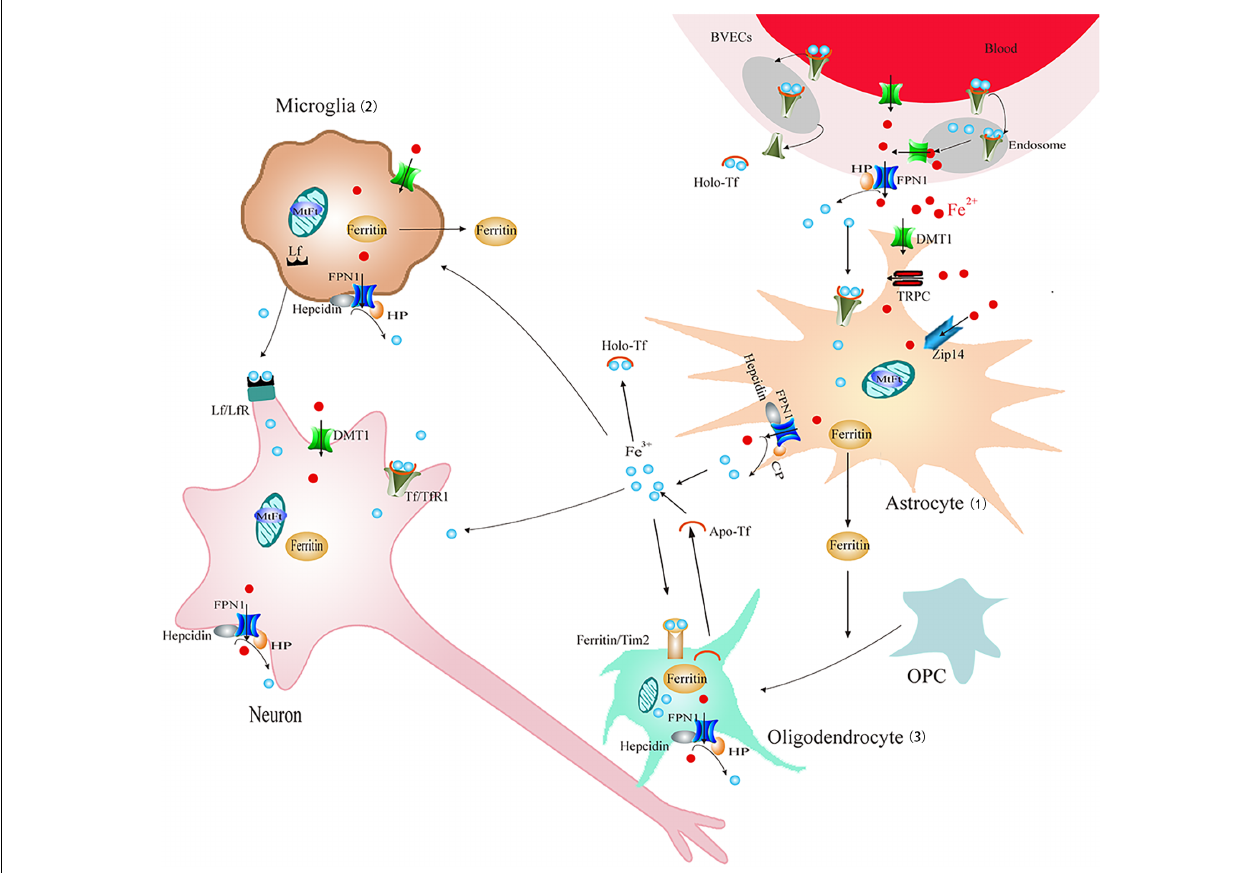
FIGURE 2 | Schematic illustration of brain iron metabolism. Iron could cross BBB though endocytosis of holo-Tf followed by iron detached from Tf inside endosomes and FPN1-mediated iron efflux or transcytosis of holo-Tf through the BVECs. (1) Astrocyte: astrocytes could uptake Fe 3 + via Tf-TfR1. DMT1, Zip14, and TRPC participate in Fe 2 + absorption. Cp can oxidize Fe 2 + to Fe 3 + and then promote FPN1-mediated Fe 2 + release. Iron can be stored in ferritin efficiently. (2) Microglia: Fe 2 + could be transported via DMT1-mediated iron import and FPN1-mediated iron export. Microglia also can transfer Fe 3 + ions to neurons by Lf/LfR-mediated pathway and store iron in ferritin. (3) Oligodendrocytes: iron is stored in oligodendrocytes mainly in the form of ferritin or Tf. Tf could be released from oligodendrocytes. Tim2-induced ferritin uptake is considered as the main mechanism for iron intake. Ferritin released from astrocyte and microglia promotes OPC maturation. BBB, blood–brain barrier; BVECs, brain capillary endothelial cells; Cp, ceruloplasmin; FPN1, ferroportin1; Lf/LfR, lactoferrin/lactoferrin receptor; NTBI, non-transferrin-bound iron; OPC, oligodendrocyte precursor cell; Tf/TfR1, transferrin/transferrin receptor 1; TRPC, resident transient receptor potential channel; Zip14, Zrt/Irt-like protein